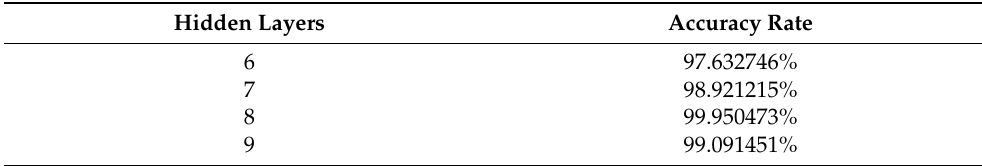
Table 4. Relationship between the hidden layers and accuracy.